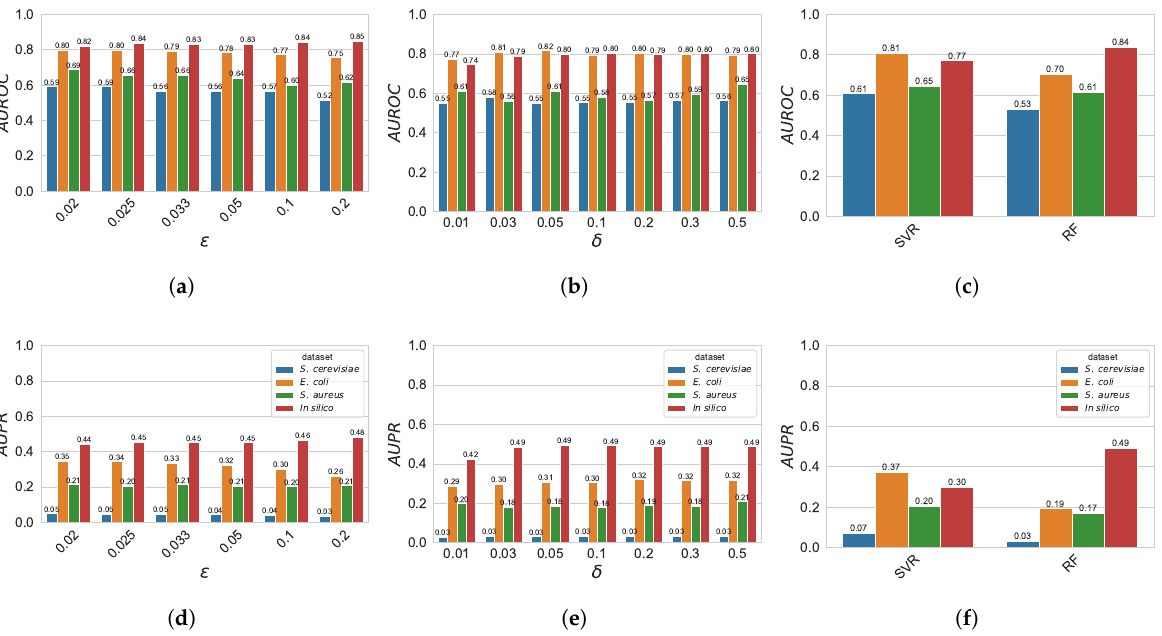
Figure 4. AUROC scores for the GXN•EN ( a ), the GXN•OMP ( b ), as well as SVR and RF ( c ) state- of-the-art models. AUPR scores for the GXN•EN ( d ), the GXN•OMP ( e ), as well as SVR and RF ( f ) state-of-the-art methods. These results were obtained, on the DREAM5 dataset; ( a ) GXN•EN